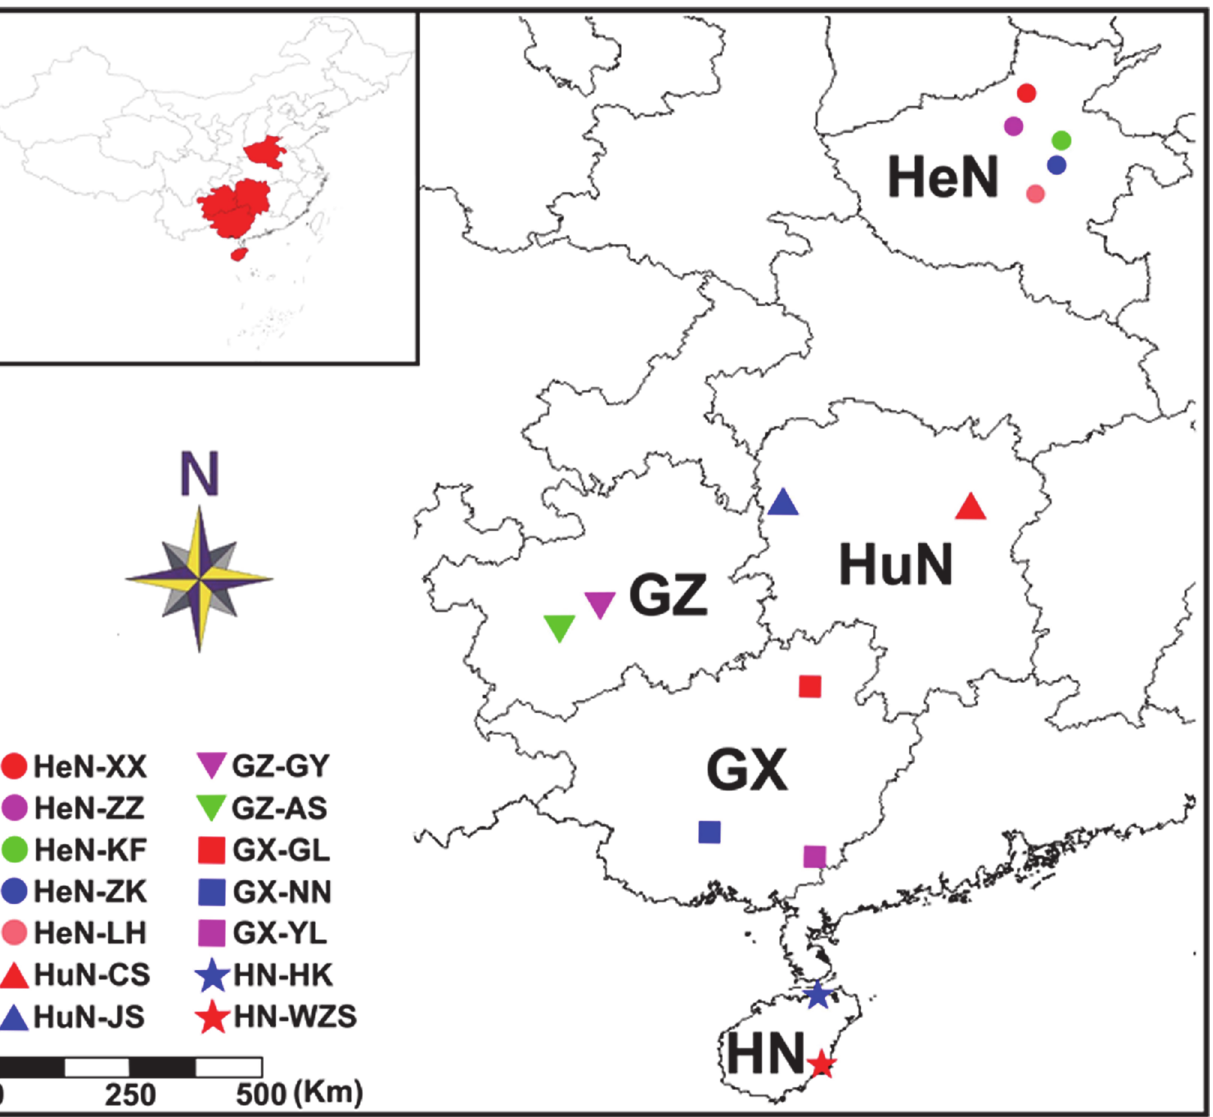
Fig 1. Map of collection localities for Spirometra erinaceieuropaei isolates. Geographic regions are designated as follows for China: Henan Province (HeN), Hunan Province (HuN), Guizhou Province (GZ), Guangxi Zhuang Autonomous Region (GX), Hainan Province (HN), Zhengzhou of Henan (HeN-ZZ), Kaifeng of Henan (HeN-KF), Luohe of Henan (HeN-LH), Zhoukou of Henan (HeN-ZK), Xinxiang of Henan (HeN-XX), Changsha of Hunan (HuN-CS), Jishou of Hunan (HuN-JS), Yulin of Guangxi (GX-YL), Guilin of Guangxi (GX-GL), Nanning of Guangxi (GX-NN), Guiyang of Guizhou (GZ-GY), Anshun of Guizhou (GZ-AS), Haikou of Hainan (HN-HK), Wuzhishan of Hainan (HN-WZS).